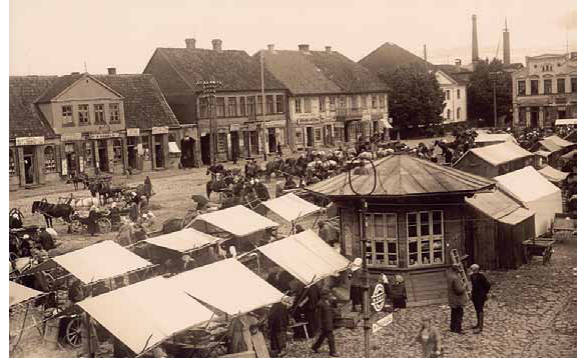
Fig. 3. Plūdoņa street near the Town Hall Square has retained its architectural and historic building structure, with no specific tree plantations. Source: author’s photo,